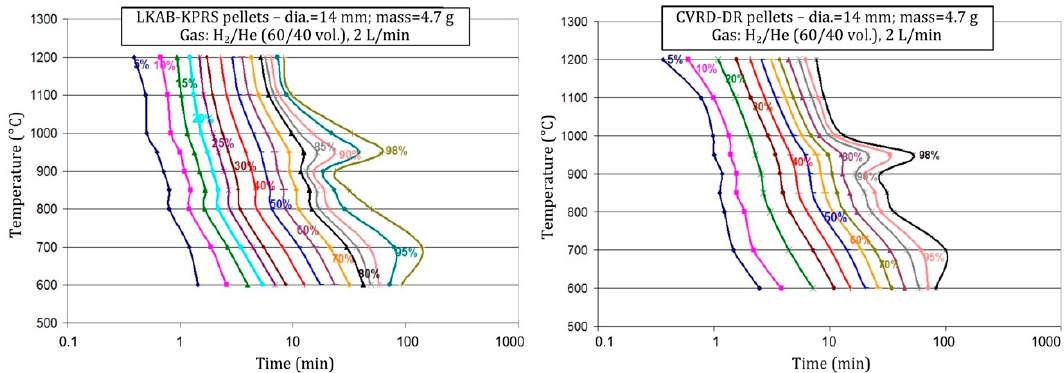
Figure 5. Kinetics of iron ore pellet reduction by H 2 plotted as a TTT diagram.